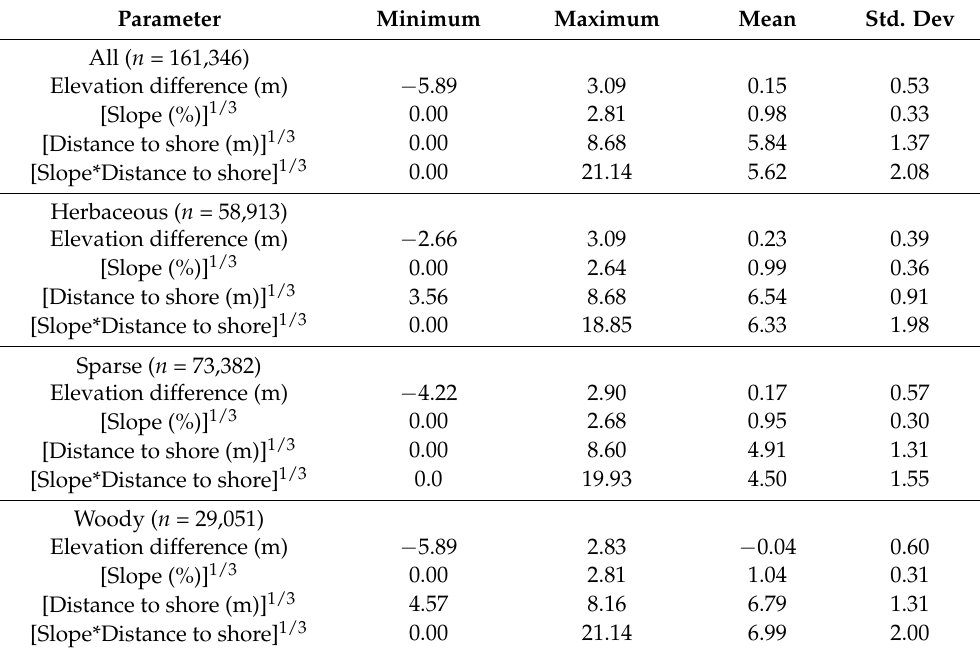
Table 3. Raster summary statistics (minimum, maximum, mean, and standard deviation), grouped by habitat, of the transformed DEM-derived metrics. The * means \ times.